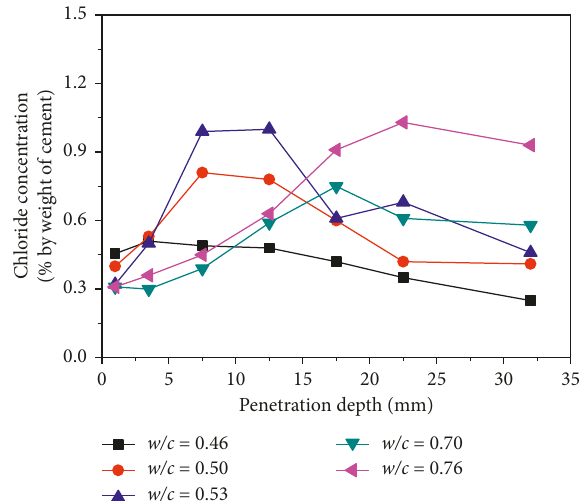
Figure 3: Concentration profiles of concrete with different w / c ratios exposed to natural marine environments [5].